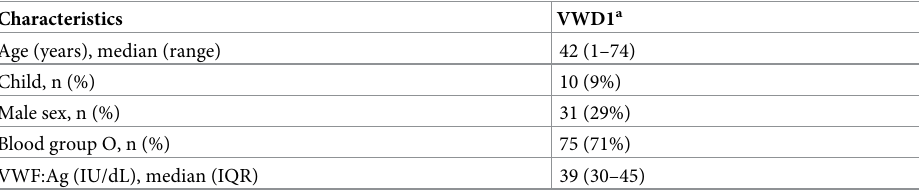
Table 1. Baseline